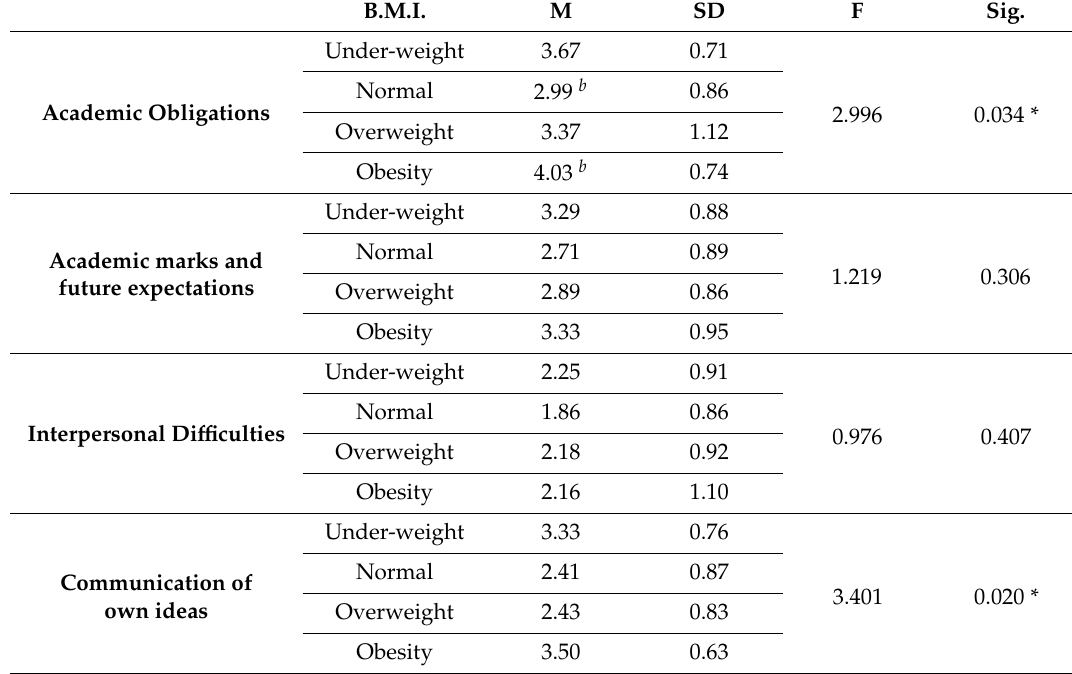
Table 2. Relationship between academic stress and body mass index